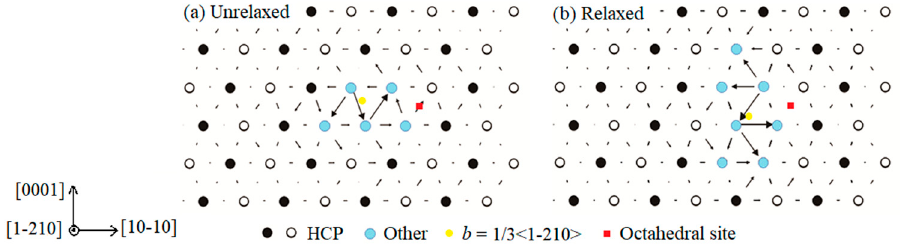
Figure 2. Core structures of full < a > -type dislocation with the introduction of interstitial oxygen atom before and after relaxation. Oxygen atoms were inserted in the octahedral site (Site A) marked as red squares in the vicinity of the dislocation core.